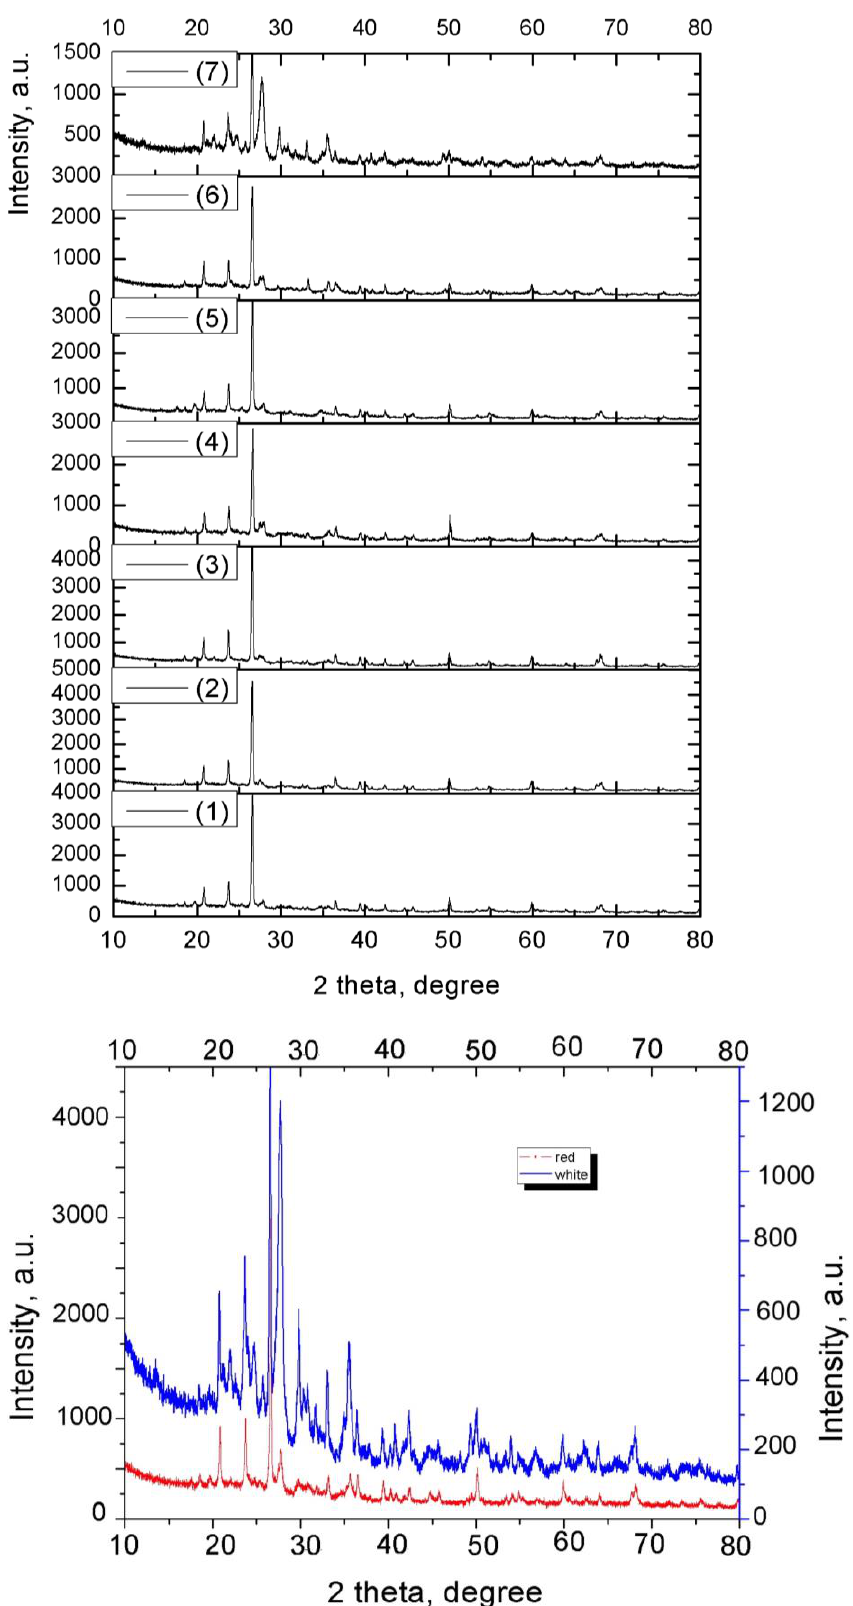
Figure 3. XRD spectra for the ceramic substrate (red) and the white encrustation. The explanation of (1) – (7) is the same with the codification from Table 1.